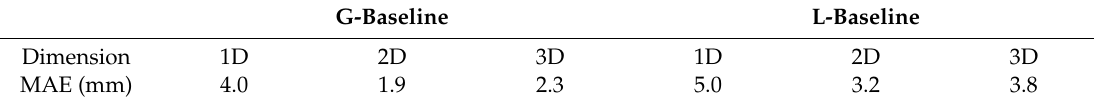
Table 11. Mean Absolute Error (MAE) for evaluated 1D, 2D, and 3D